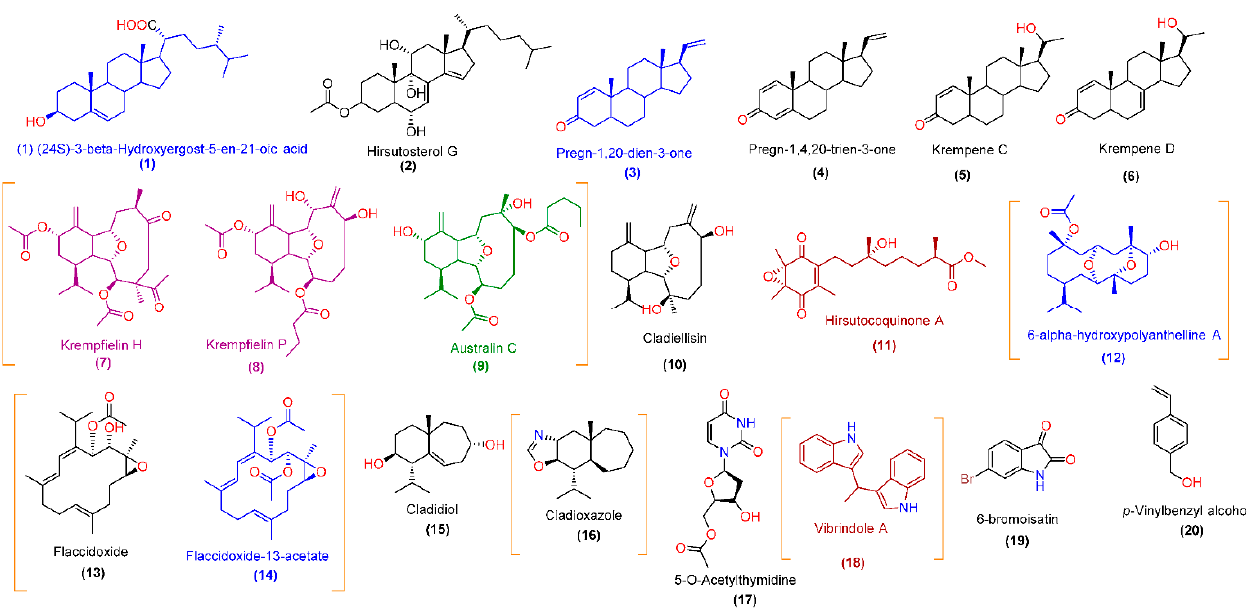
Figure 5. Chemical structures of major compounds 1 – 20 (peak area > 10,000) that have been annotated in CE. According to the pdCSM-cancer software, blue-colored compounds ( 1 , 3 , 12 , and 14 ) were predicted to have general anticancer activity; purple-colored compounds ( 7 and 8 ) were predicted to have anticancer activity against MCF7 and MDA-MB-231 cell lines; brown-colored compounds ( 11 and 18 ) were predicted to have anticancer activity against MCF7 only. The green-colored compound ( 9 ) was predicted to have general anticancer activity along with specific anticancer activity towards MCF7 and MDA-MB-231 cell lines. According to the CLC-Pred software, compounds between orange parentheses were predicted to be active (Pa > 0.5) against either MCF7 (compounds 7 – 9 and 16 ) or MDA-MB-231 cell lines (compounds 12 – 14 and 18 ). Black ‐ colored compounds were inactive according to both prediction software platforms.